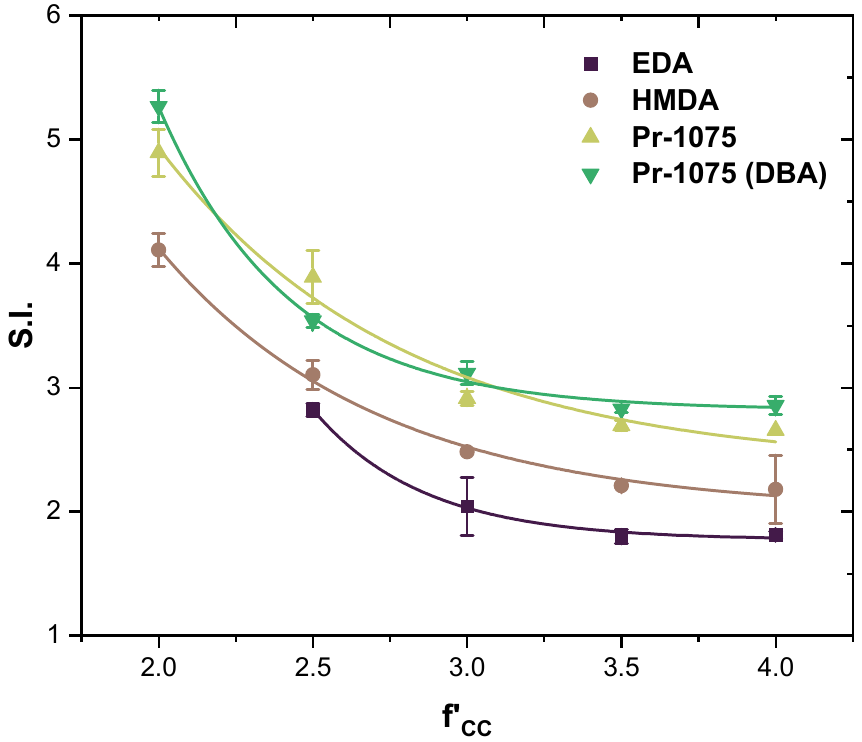
Figure 6. Swelling index results for the f ′ CC study.